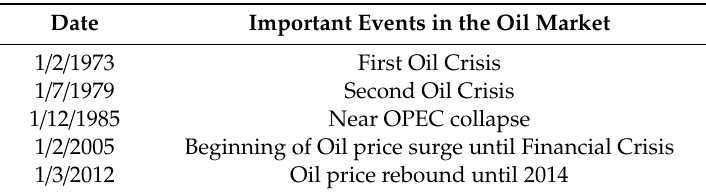
Table 3. Structural oil price breakpoints and important